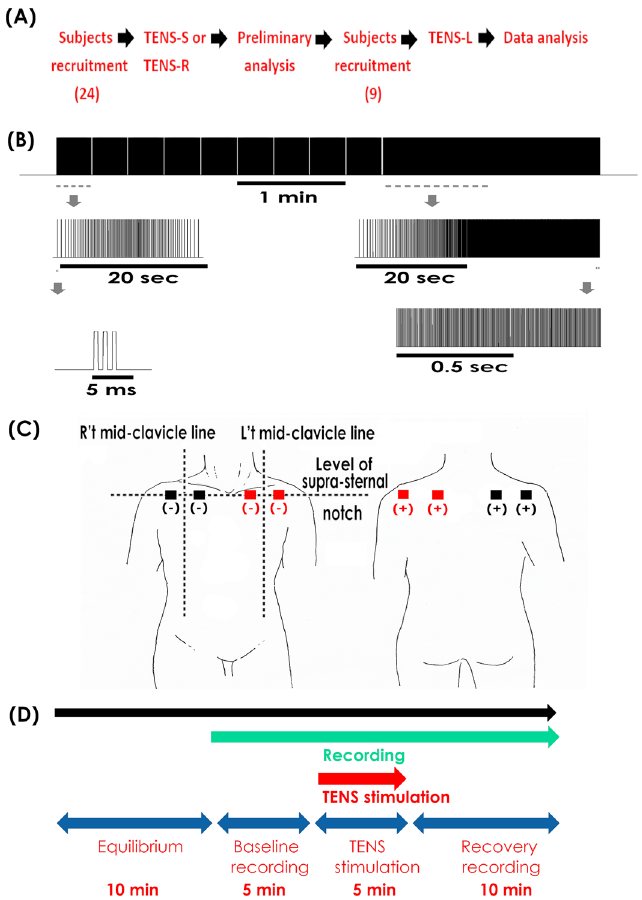
Figure 1. ( A ) The flow chart of participant recruitment and data analysis. Initially, 24 subjects were assigned to receive either the sham stimulation (TENS-S) or TENS on the right shoulder (TENS-R). After the preliminary analysis, 9 additional subjects were recruited and tested with TENS on the left shoulder (TENS-L). Data obtained from all experiments were then collectively analyzed. ( B ) The waveform of TENS. The upper trace is the waveform of TENS used in the current study. Waveform marked by the dash lines is amplified as the middle traces. Bottom left: each spike is a triple pulse with 1 ms pulse duration and each separated by a 1 ms interval. Bottom right: the frequency maintained at 200 Hz in the late period of stimulation. ( C ) The location of electrodes of TENS. Black blocks indicate the location of electrodes in TNES-S and TENS-R; red blocks indicate that in TENS-L. Stimulating electrodes ( −) were placed in the front of the should at the level of the suprasternal notch at about 2 finger-width medial and lateral from the mid-clavicle line; dispersive electrodes ( +) were placed at the back of the shoulder opposite to the stimulating electrodes. ( D ) The follow chart of TENS application. Before the stimulation, there was an equilibrium period of 10 min and then the recording started for 20 min. TENS was turned on after a 5 min baseline recording and lasted for 5 min. The recording stopped at 10 min after TENS